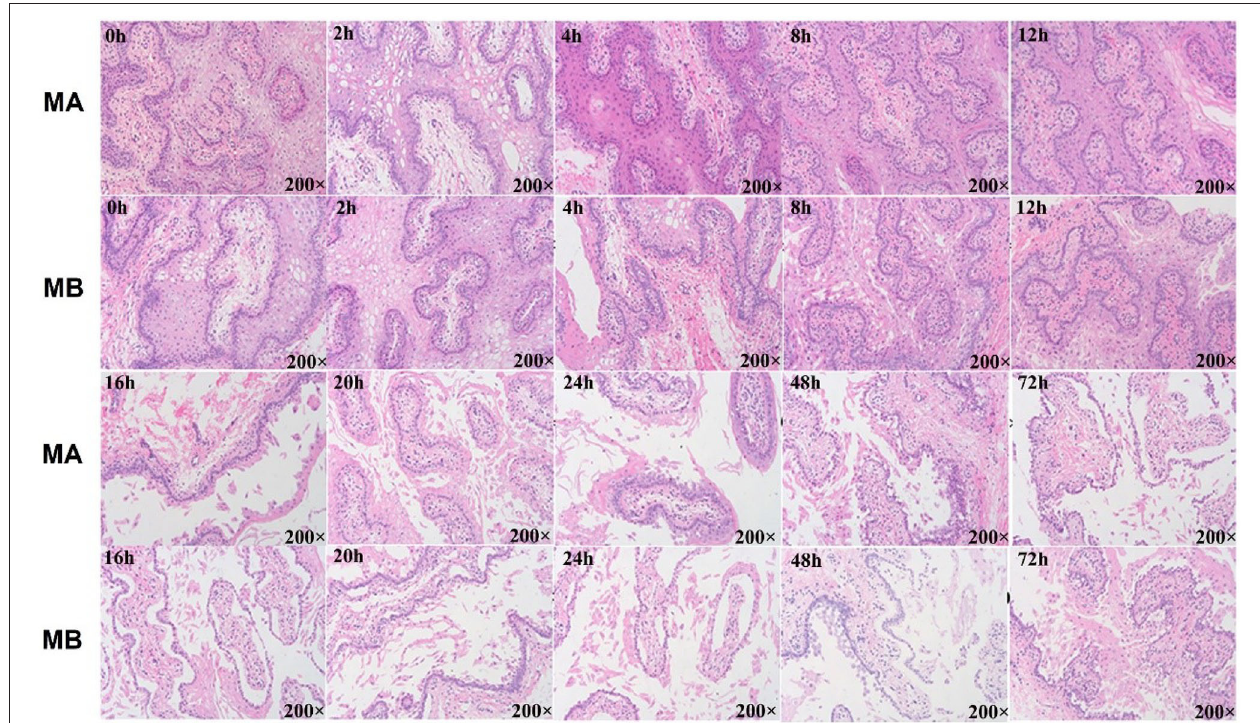
FIGURE 5 | Histology results of rumen explant tissue with different media and culture time. Hematoxylin–eosin staining (HE) or HE staining is a common method for observing the morphology and structural integrity of tissue cells. Normal physiological changes of animal explants in general or morphological changes after the addition of certain stimuli can be observed by the HE staining method. MA is rumen explant cultured in medium A containing 10% serum, and MB is rumen explant cultured in medium B without serum. The effect of different media and cultural times on the growth of rumen explants was observed by the integrity of the flat cut structure of the rumen epithelial tissue. The explant maintained a complete organizational structure at 12h but started to disintegrate after 16h and festering increased with longer cultural